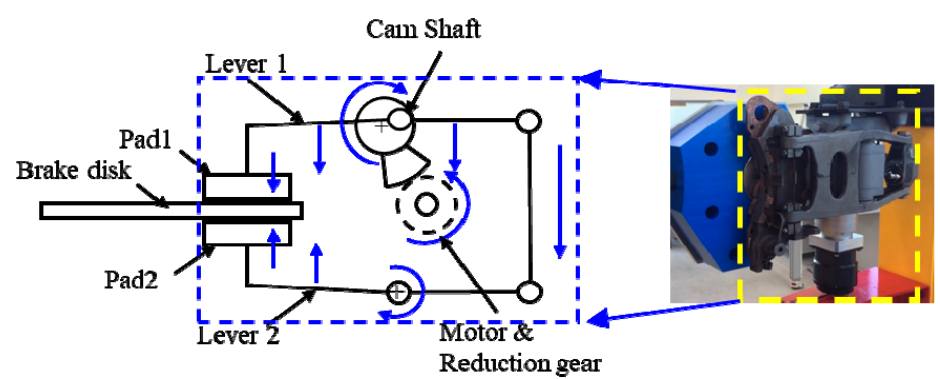
Figure 1. Electromechanical brake (EMB) structure using the three-phase interior permanent magnet synchronous motor (IPMSM).